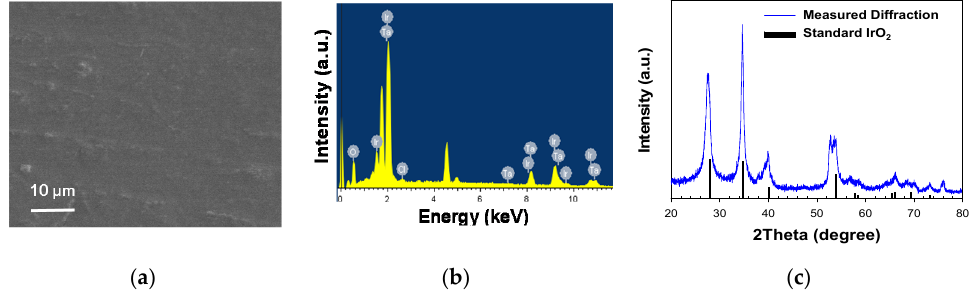
Figure 1. Morphology and composition of IrTaO x mixed metal oxide anode based on representative ( a ) horizontal SEM image, ( b ) elemental composition measured by EDX, and ( c ) crystalline structure measured by XRD referenced to a standard pattern of IrO 2 .